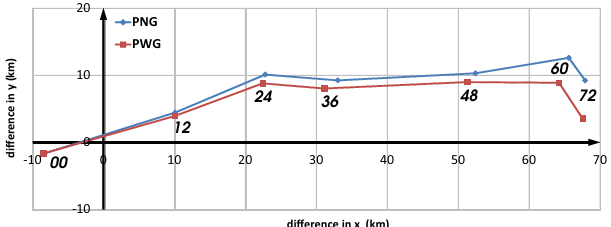
Figure 11. Mean track bias in longitude ( x axis) and latitude ( y axis)